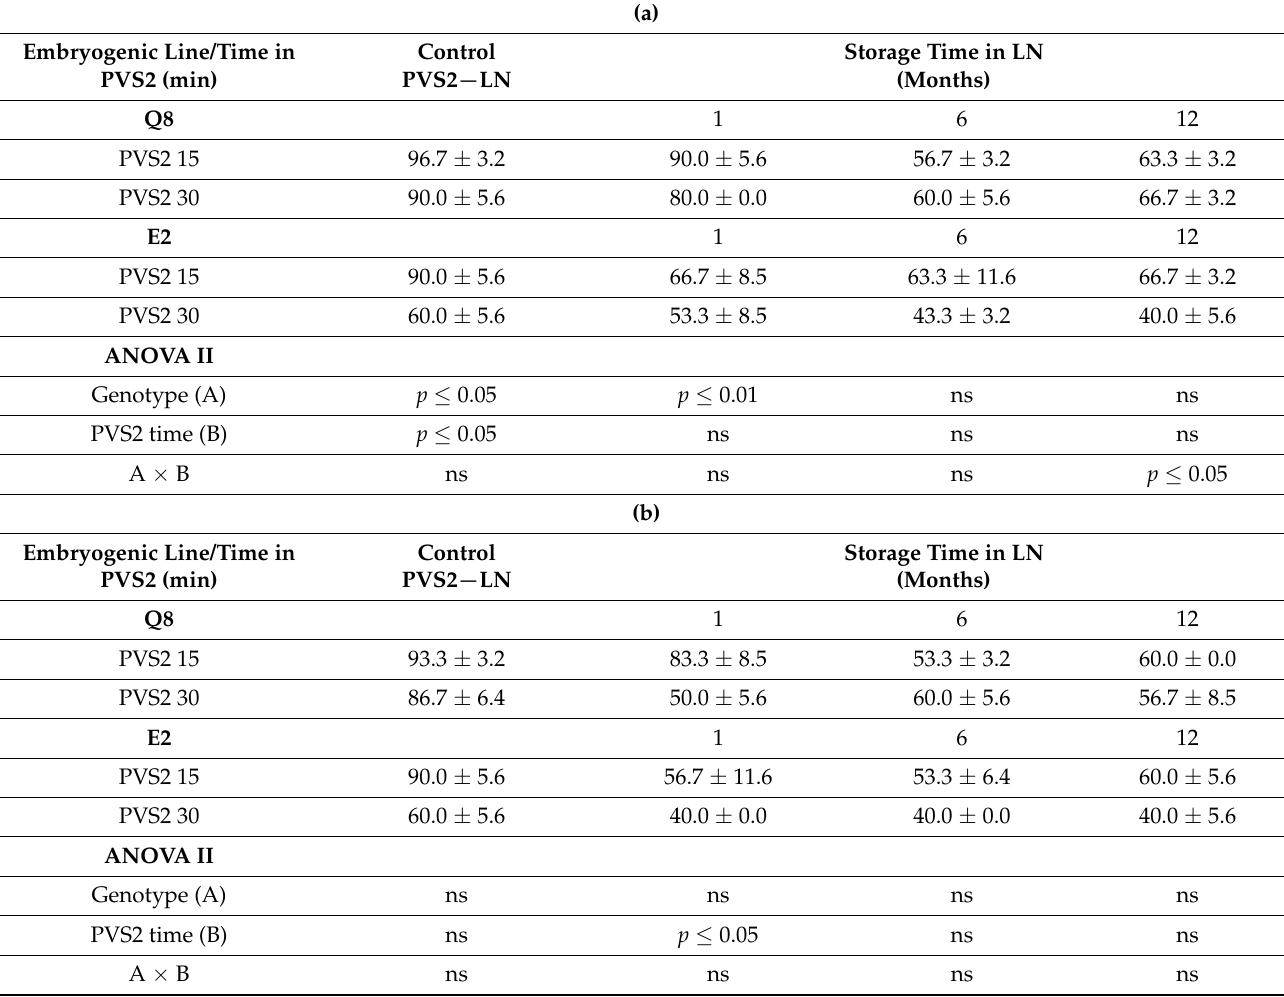
Table 2. ( a ) Survival (%) of nodular embryogenic structures of holm oak embryogenic lines (Q8 and E2) after preculture on medium containing sucrose and incubation in PVS2 solution for 15 or 30 min, with subsequent immersion in LN. ( b ) Recovery (%) of nodular embryogenic structures of holm oak embryogenic lines (Q8 and E2) after preculture on medium containing sucrose and incubation in PVS2 solution for 15 or 30 min, with subsequent immersion in LN.